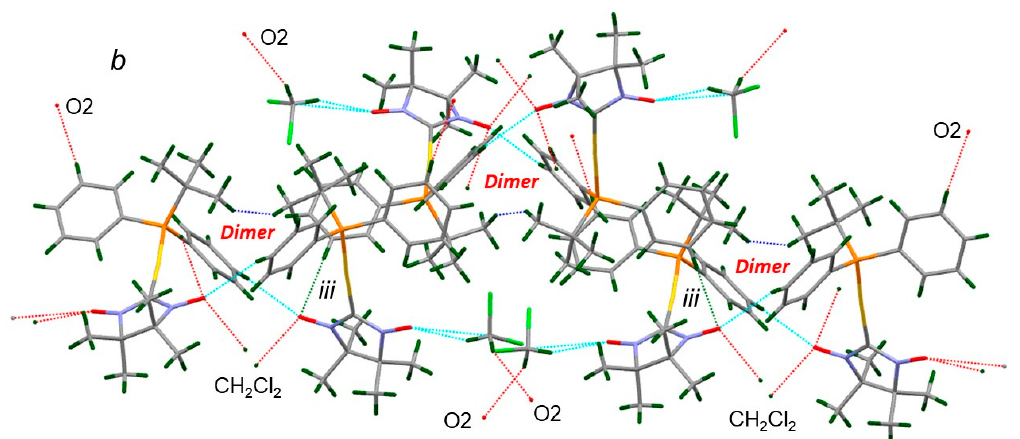
Figure 5. Short intermolecular contacts and interatomic distances in crystals of NN-Au-P t BuPh 2 ( 1 ): dimer formation ( a ), binding of the dimers info a 3D framework via contacts iii and bridging solvate molecules ( b ).